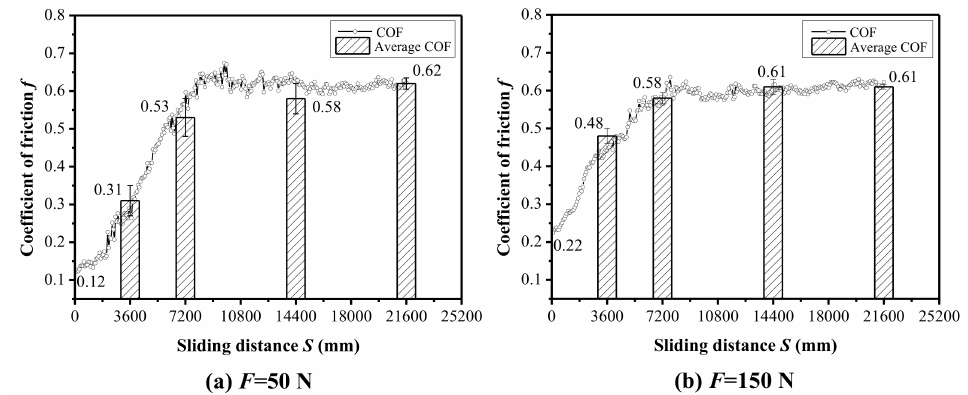
Figure 5. The evolution of the coefficient of friction under different contact loads. ( a ) Load: 50 N, stroke: 20 mm; ( b ) load: 150 N, stroke: 20